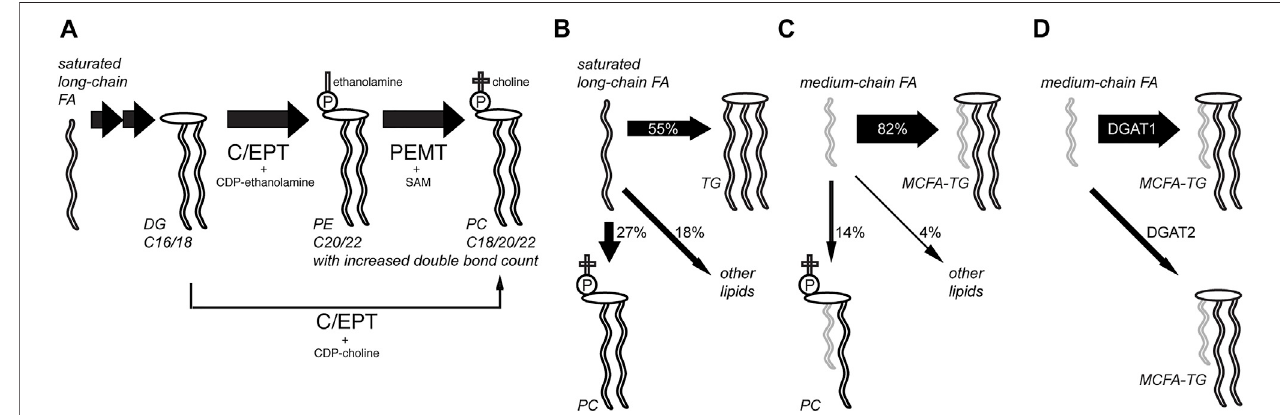
FIGURE 3 | Analysis of hepatic lipid anabolism and remodeling with alkyne FA tracers. (A) In pulse-chase experiments using primary mouse hepatocytes and various alkyne FAs, the fl ow of labels through various lipid classes and lipid remodeling was studied. Hepatocytes produced a major fraction of their abundant polyunsaturated PC species from PE by phosphatidylethanolamine N-methyltransferase (PEMT) using S-andenosyl methionine (SAM), ref. (Thiele et al., 2019). The PE precursor is produced from DG by choline/ethanolamine phosphotransferase (C/EPT) using CDP-ethanolamine as a co-substrate. The more direct pathway from DG to PCwith C/EPT using CDP-cholineisless prominent in theliver. Following asaturated long-chainFA, thisPC synthesis via PEisaccompanied bylipid remodeling, yielding an increased average side-chain length and double-bond counts over time. The TG and PI pools were also analyzed. (B,C) Compared to saturated long-chain FAsthatwereassimilatedquitebroadlyintovariouslipidclassesafter6 h (B) ,medium-chainFAslabeledprimarilytheTGpool (C) ,ref.(Kuerschneretal.,2022). (D) Major part of medium-chain fatty acid TG (MCFA-TG) was synthesized by diacylglycerol acyltransferase 1 (DGAT1) whose activity can only be partially substituted by DGAT2, ref. (Wunderling et al.,